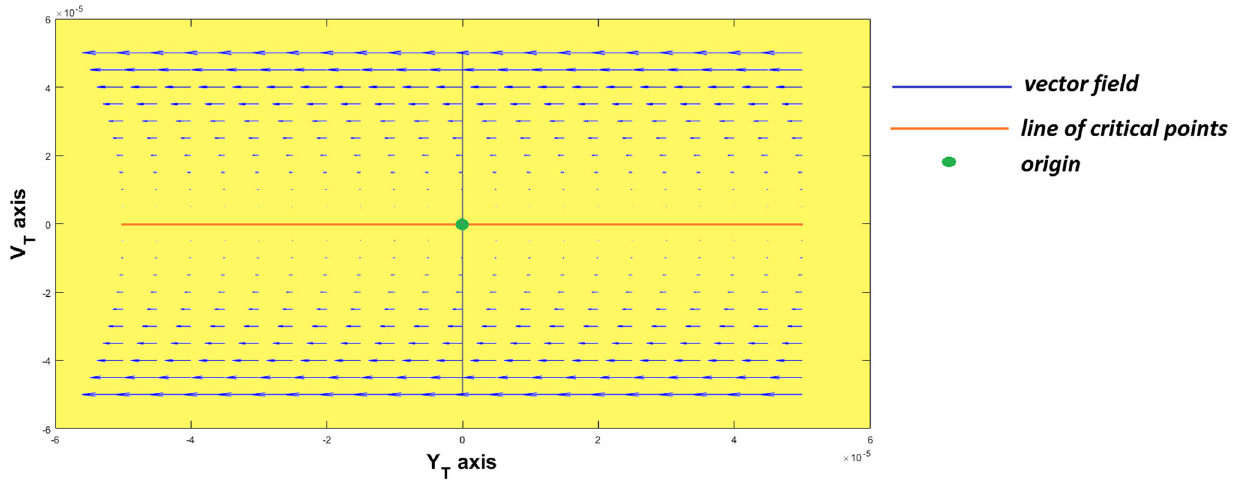
Fig. 3 Vector field near the origin in Y T V T -plane for α = − 3. After shifting and matrix transformation, the line of critical points B 3 (in the old coordinate system ( x , y ,v, u ) ) is completely lying on the Y T axis in the new coordinate system. For determining this vector field we have